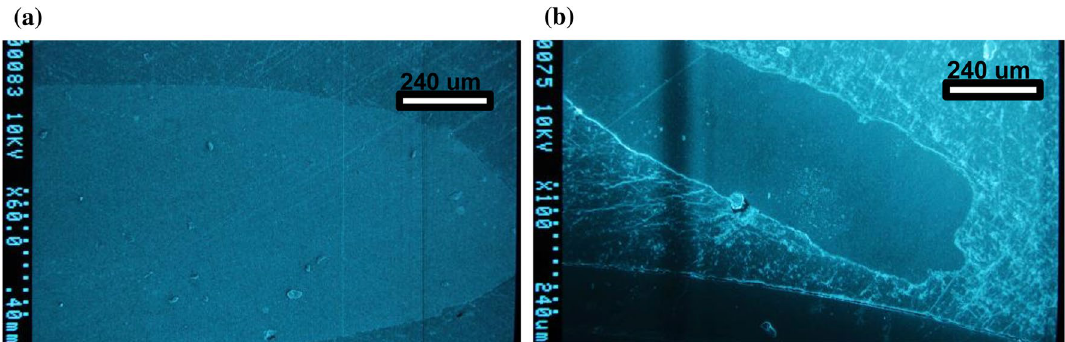
Fig. 1 SEM analysis of the surface of a Bone Easy samples and b BTK samples. Small internal defects can be observed, more evident in the internal part of the device ( a ), while the device ( b ) shows a more regular surface and a rougher profile